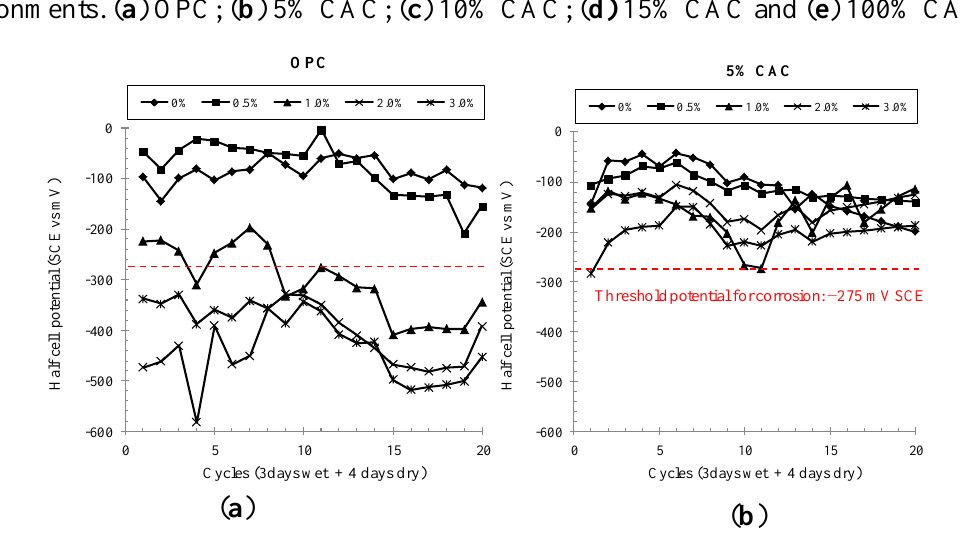
Figure 4. Corrosion potential of steel in CAC and OPC mortar subjected to